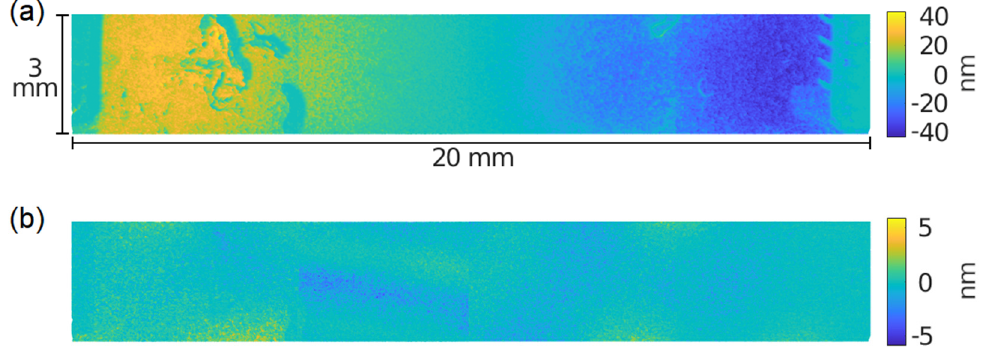
Figure 10. Optical measurement of the displacement of the first extensional mode of the PZT plate with legs at both the bottom and the top. ( a ) In-plane displacement. ( b ) Out-of-plane displacement.